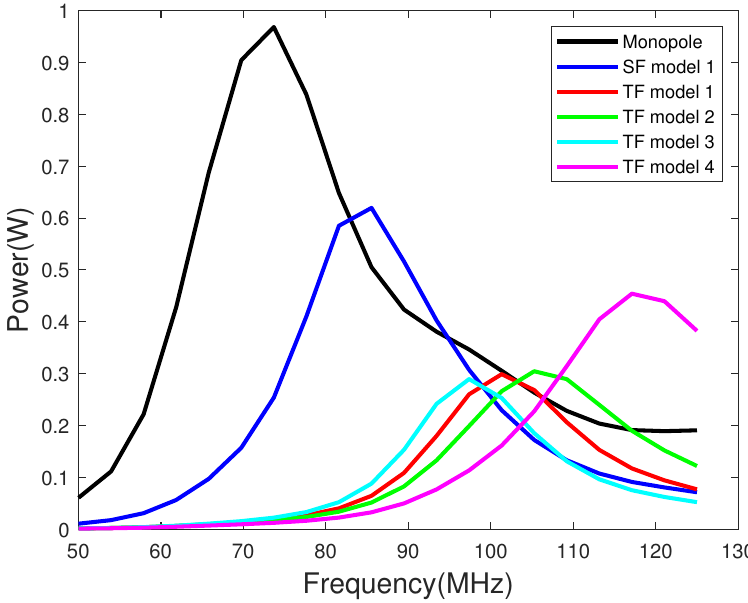
Figure 10. Far-field radiated power vs. the frequency of operation.